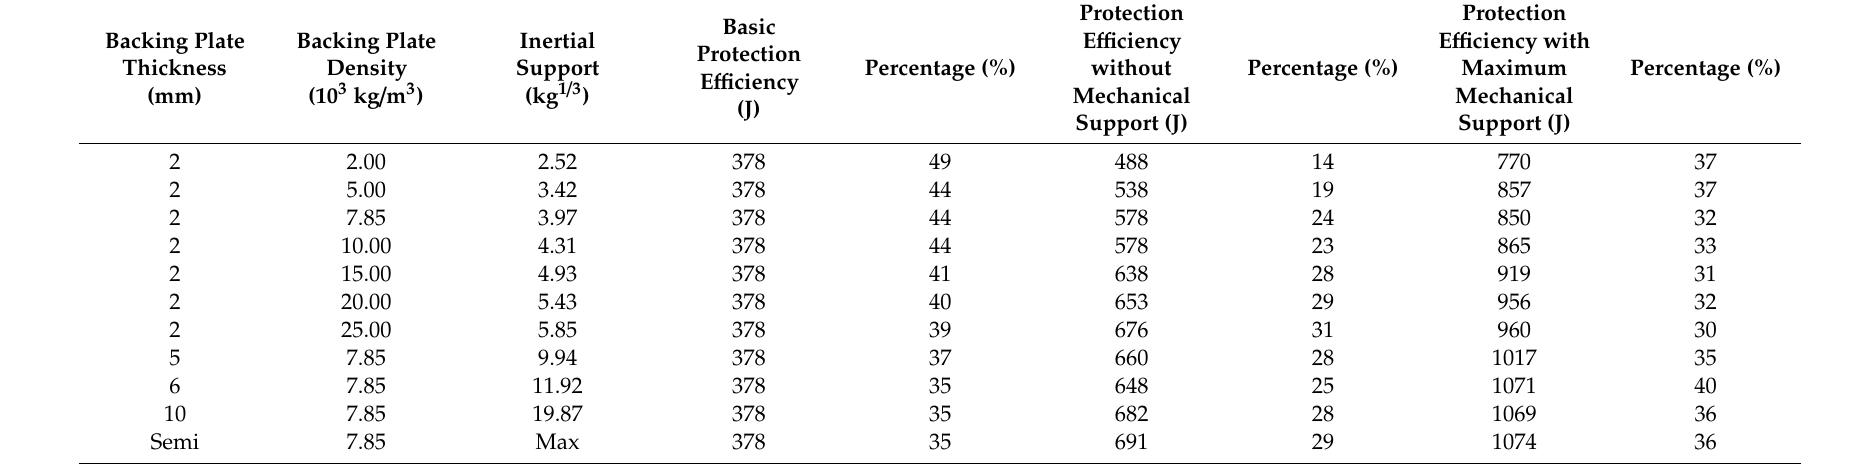
Table 8. Energy dissipation gain of mechanical bracing under di ff erent inertial bracing